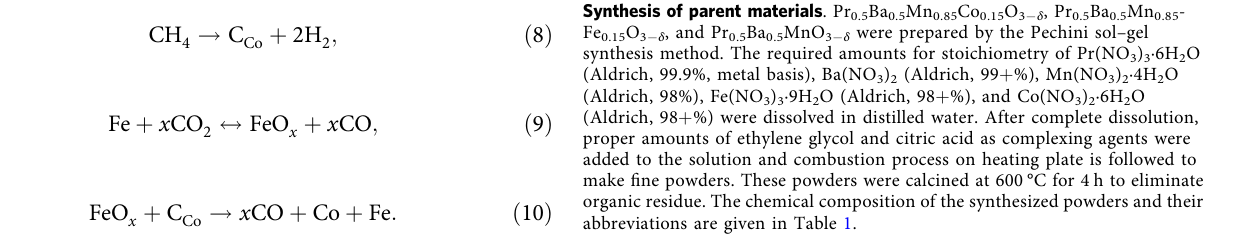
reactions involving CO 2 oxidation and CH 4 reduction during DRM are given by the following steps (Eqs. (8 – 10)) according to a Mars-van Krevelen (MvK) mechanism 28 . That is, Co – Fe alloy particles undergo de-alloying/re-alloying process during DRM and, consequently, FeO on the surface reacts with carbon deposited on Co to form CO (Eq. (10)).